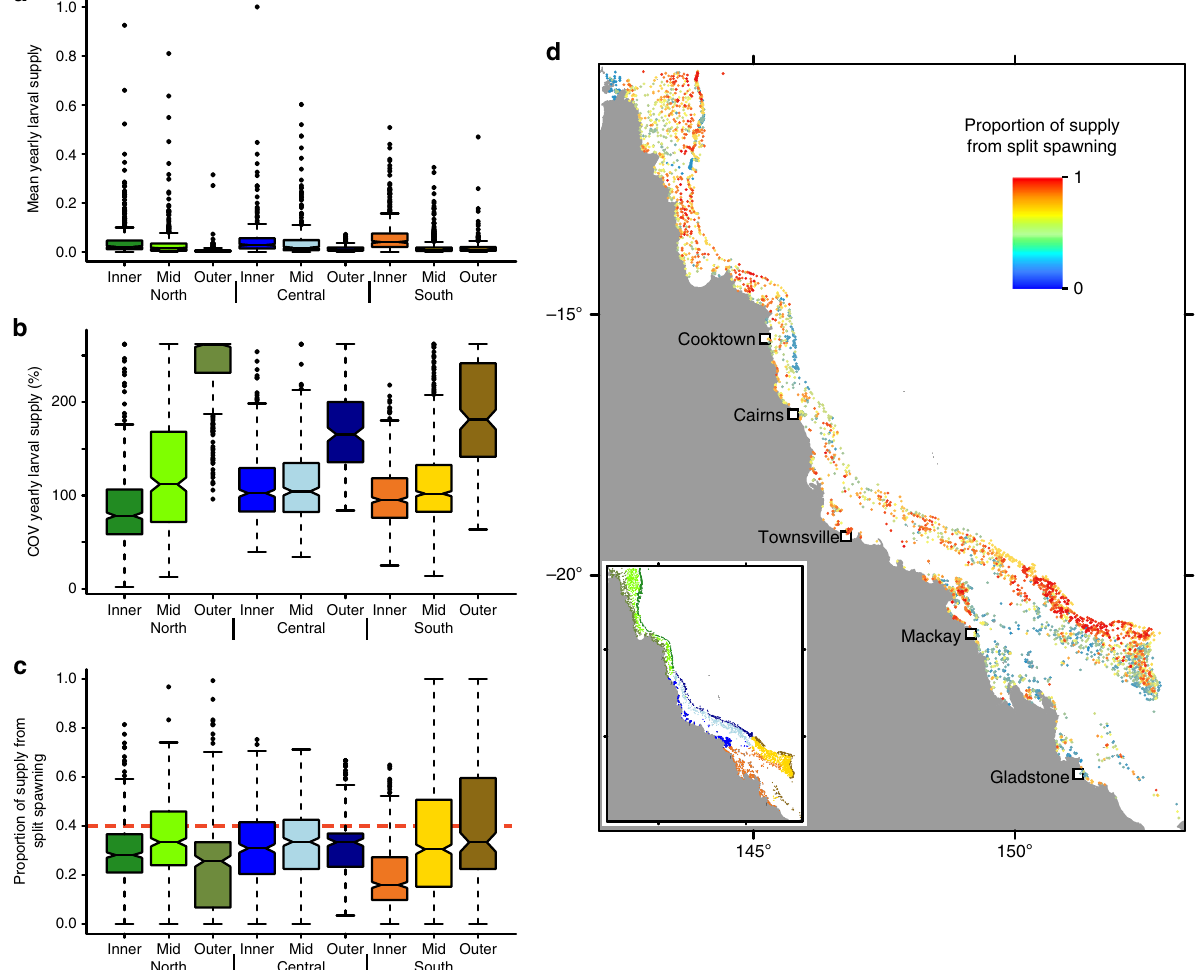
Fig. 2 Patterns of larval supply and the effects of split spawning. Spatial patterns in ( a ) the relative magnitude of larval supply (normalised to 0 – 1), during the seven years of dispersal simulations, and ( b ) temporal variation in supply expressed as the coef fi cient of variation of relative supply per year. ( c ) Sensitivity of larval supply to split spawning as indicated by the mean proportion of annual coral larval supply contributed by the second spawning in split spawning scenarios during which 40% of larvae were released. Departures from the null expectation of 0.4 (red dashed line) imply that supply would have been highly sensitive to a spawning month had there been only a single spawning event. ( d ) Map showing locations of reefs and the mean proportion of supply contributed to each reef by the second spawning in the split spawning scenarios. The colours of the boxes in panels ( a ), ( b ) and ( c ) correspond to the colour scheme of the GBR sectors shown in the inset in panel ( d ). In boxplots, the centre line represents the median, the upper and lower limits of the box represent the third and fi rst quartile respectively, the notches in the boxes represent the con fi dence interval around the median (equal to ±1.58 times interquartile range divided by square root of the sample size), the whiskers extend up to 1.5 times the interquartile range from the bounds of the box, and the points represent outliers beyond the limits of the whiskers. In ( d ) blue hues show reefs that received much of their larval supply in the fi rst spawning of the year, red hues show reefs that received much of their larval supply in the second spawning of the year, and yellow hues show reefs that received comparable amounts of larval supply from both spawnings in a year. COV = coef fi cient of